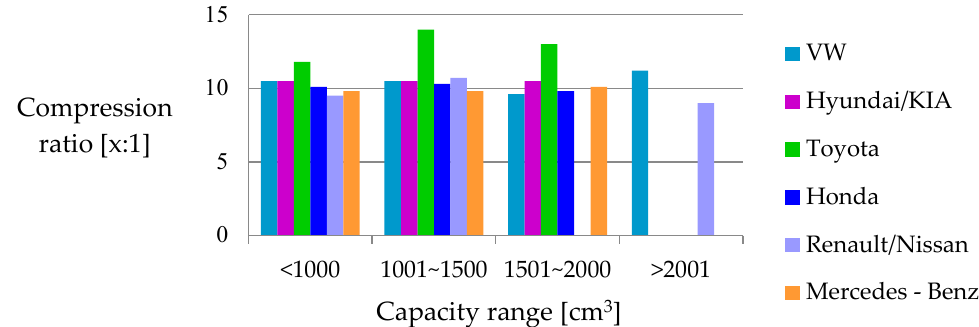
Figure 3. Compression ratio in the individual engine capacity compartments; European and Asian car brands. Source: Developed own.